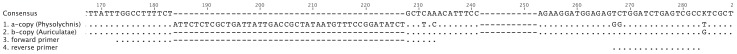
Primers designed specifically to fit the NRPA2 b-copy.Both primers were located in regions where all Physolychnis and Auriculatae b-copies were identical, and differing from the Physolychnis a-copy.